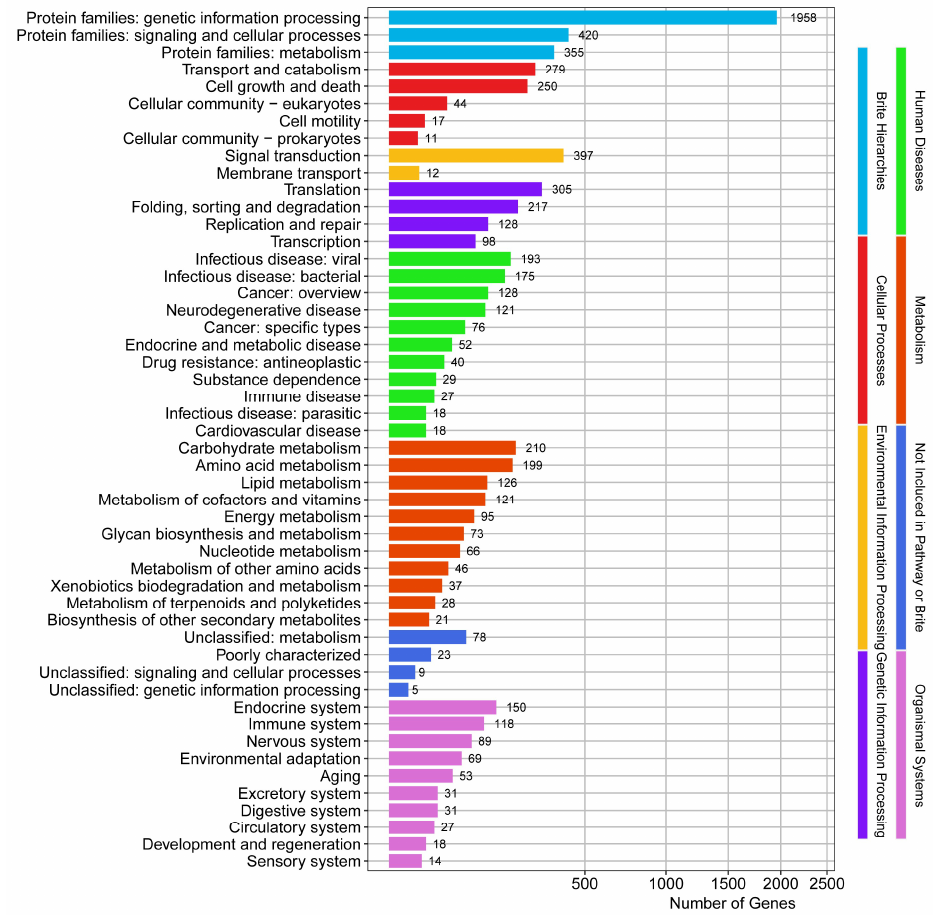
Figure 4. KEGG classification of S. bacillaris CC-PT4 genome.